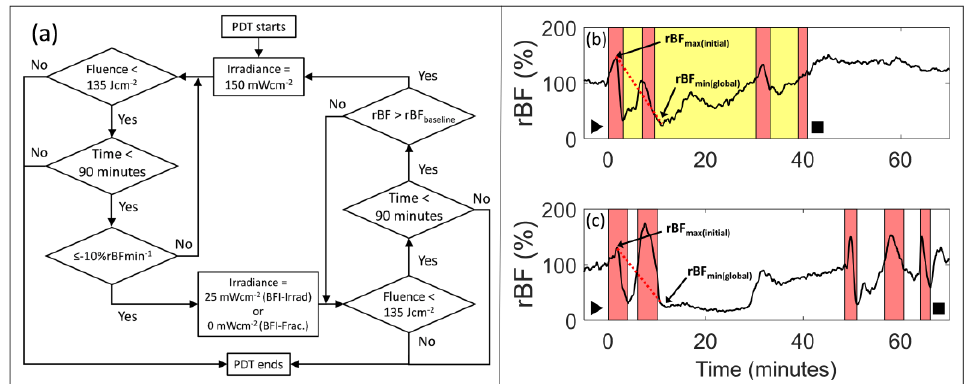
Figure 3. ( a ) Flow chart of the process for blood-flow-informed (BFI) light delivery. Irradiances are either 150 mWcm − 2 or 25 mWcm − 2 for BFI-Irrad PDT; and 150 mWcm − 2 or 0 mWcm − 2 for BFI-Frac photodynamic therapy (PDT). Representative blood flow traces for ( b ) blood-flow-informed irradiance light delivery (BFI-Irrad) and ( c ) blood-flow-informed fractionated light delivery (BFI-Frac) of radiation-induced fibrosarcoma (RIF) tumors. Light delivery is shaded in red or yellow for illumination at 150 mWcm − 2 or 25 mWcm − 2 , respectively. ► and ■ indicate the initiation and completion of light delivery, respectively. rBF max(initial) and rBF min(global) are the respective first peak and global minimum of tumor blood flow during light delivery. Dashed red lines in each plot represents the slope of the decrease in rBF between rBF max(initial) and the rBF min(global) , described as the overall flow reduction rate.